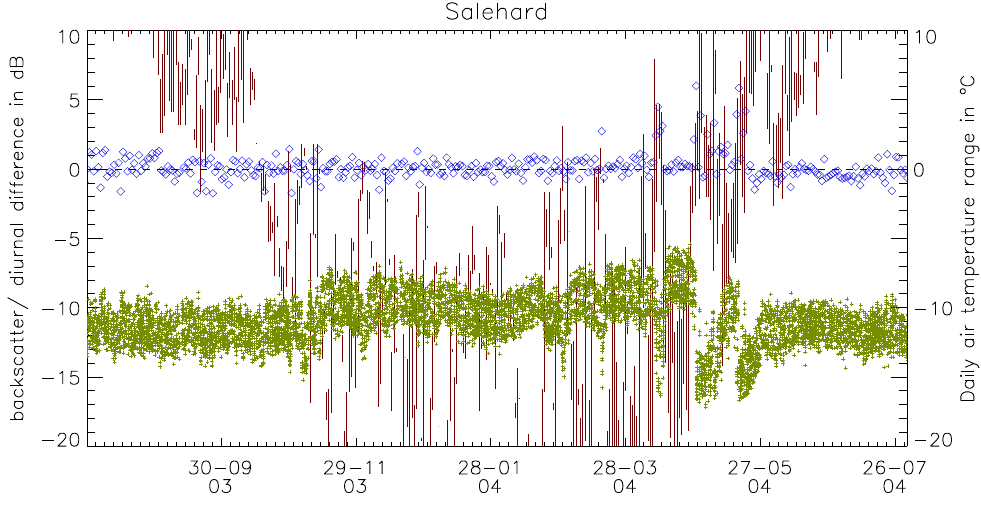
Figure 1. SeaWinds on QuikSCAT timeseries example from autumn 2003 to spring 2004 (Salehard, 66.53 ◦ E, 66.53 ◦ N). Backscatter of all available measurements in dB (green +) compared to daily temperature range (red vertical bars show minimum to maximum in degree Celsius; source: WMO D512 dataset). Blue diamonds represent the difference between average morning and evening backscatter in